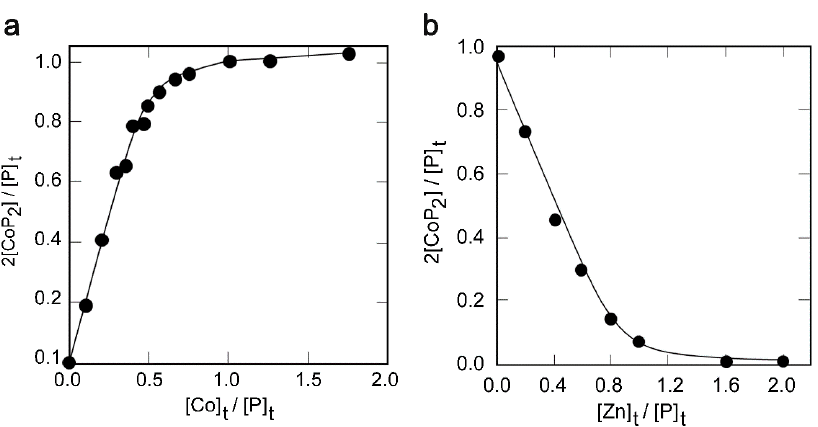
Figure 3. ( a ) Spectrophotometric titration of METP3 peptide with Co(II). The saturation fraction 2[CoP 2 ]/[P] t is plotted against the concentration ratio [Co] t /[P] t . Solid line shows the best fit of data points to Equation (1). ( b ) Spectrophotometric competition experiment of Co(II)-METP3 complex with Zn(II). The saturation fraction 2[CoP 2 ]/[P] t is plotted against the concentration ratio [Zn] t /[P] t . Solid line shows the best fit of data points to Equation (2).